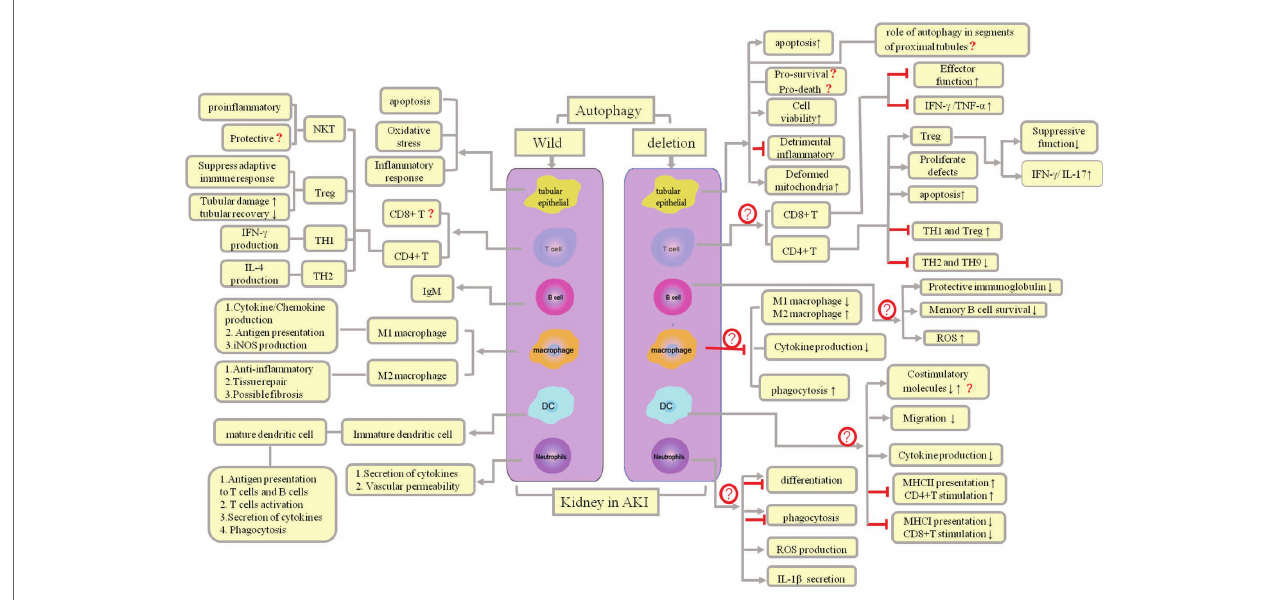
FIGURE 3 | Autophagy and inflammation regulation and outcomes in AKI. Both infectious and noninfectious processes can trigger an inflammatory response, following which parenchymal cells and immune cells can induce AKI, which, in turn, lead to influx of innate immune cells, mainly macrophages, neutrophils, and natural killer (NK) T cells. Both cells of the innate immune system and adaptive immune effector cells are responsible for subsequent damage (Th2 cells plasma B cells) and repair (Th1 and Treg cells, M2